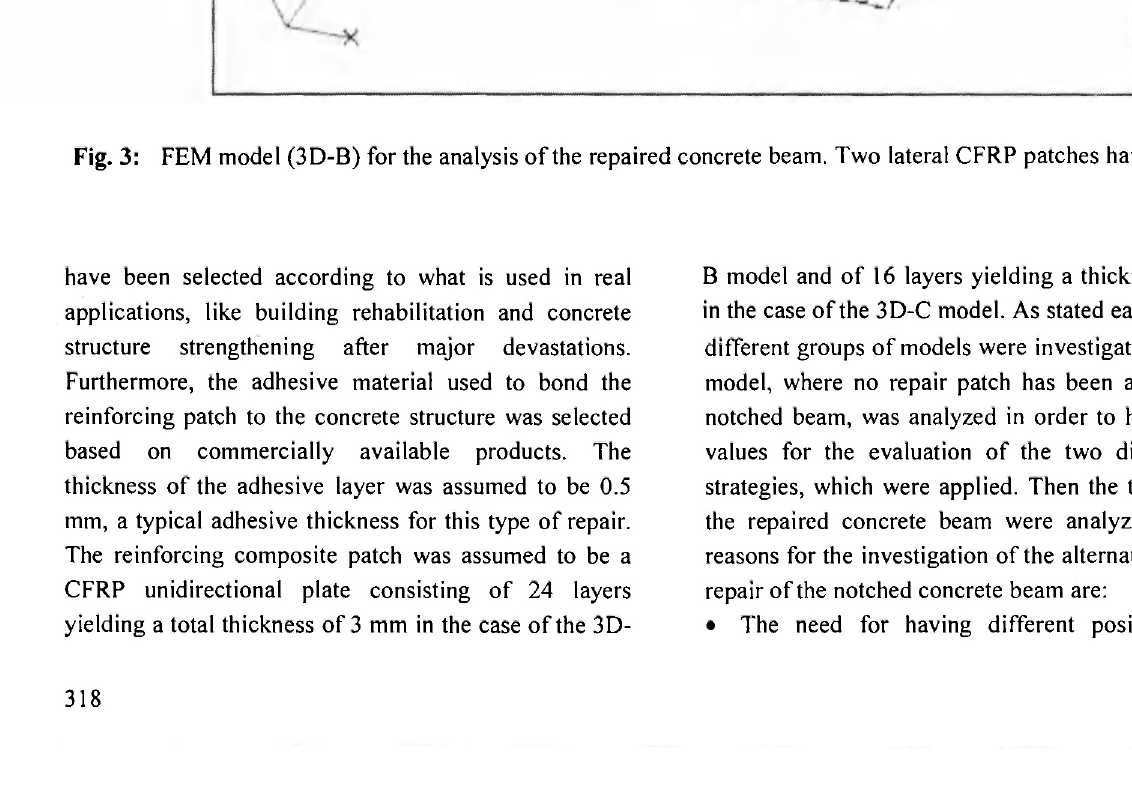
have been selected according to what is used in